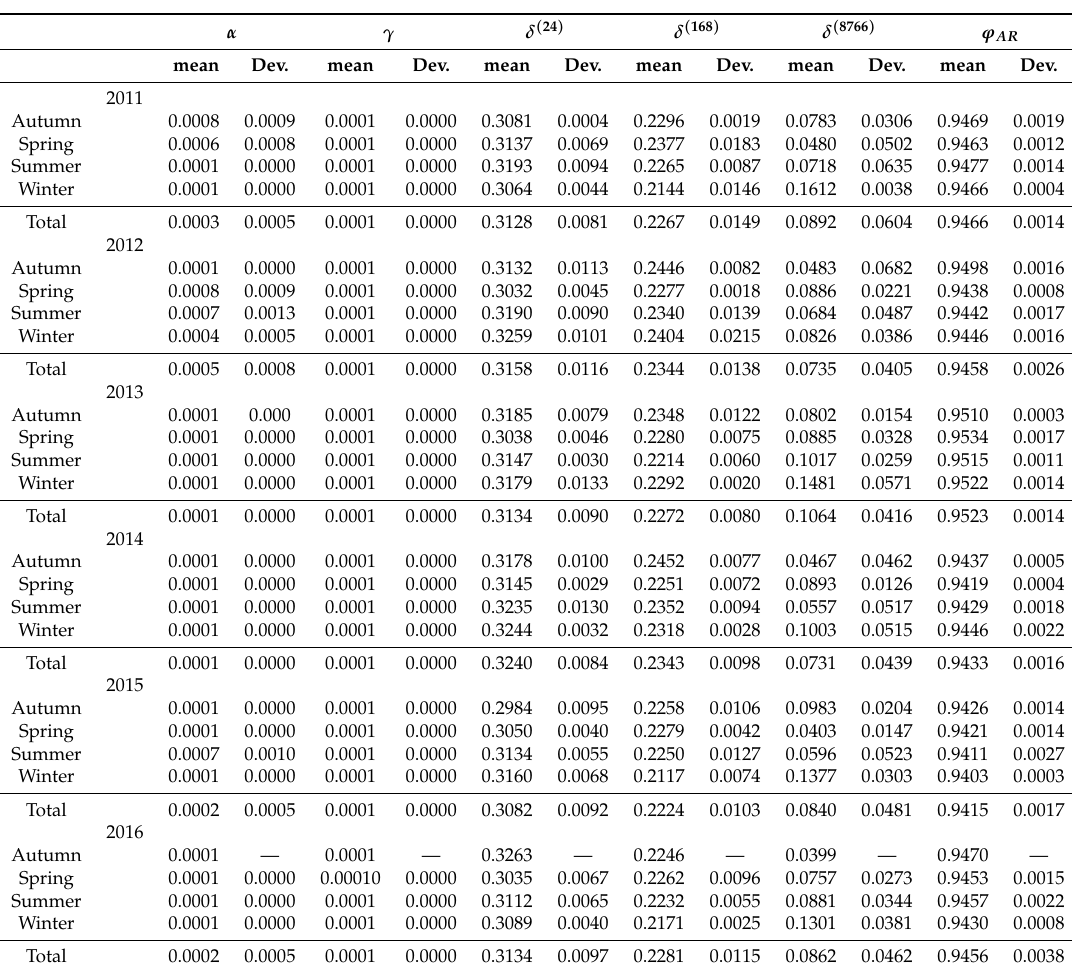
Table 4. Distribution of smoothing parameters of the AMC 24,168,8766